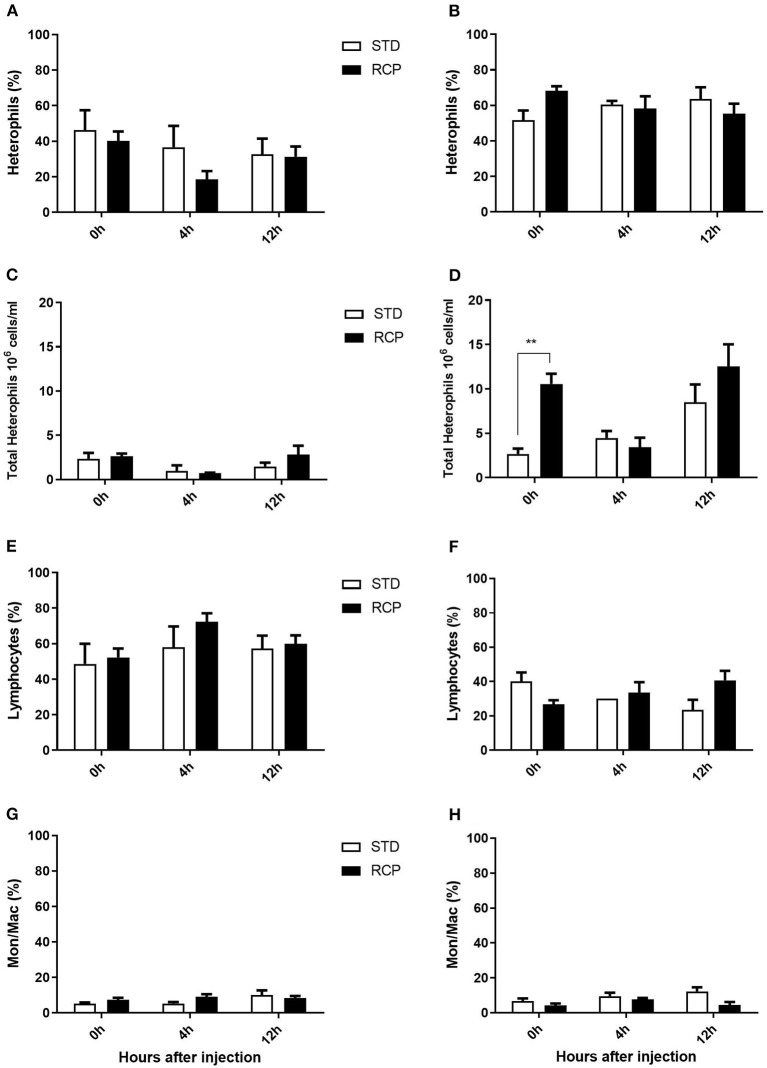
Impact of reduced crude protein diet on heterophil, lymphocyte, and monocyte/macrophage on peripheral blood leukocyte composition following an in vivo zymosan challenge. Changes to blood heterophil percentages [d 14 (A); d 35 (B)] and absolute numbers [d 14(C); d 35 (D)]. Parallel changes to the percentage of lymphocytes d 14 (E) and d 35 (F), and monocyte/macrophages d14 (G) and d 35 (H). **P < 0.01 between different treatments. RCP, Reduced Crude Protein; STD, Standard diet; n = 5.